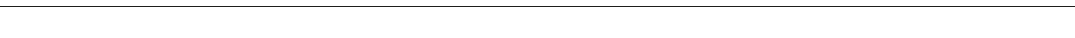
Fig. 7 Integration rules in the middle body patch. a Coronal slice showing the location of the fMRI-identi fi ed middle body patch in one monkey targeted for recording; dark black line indicates electrode. b Example stimuli used to probe integration rules in the middle body patch. The face image is from the FERET face database 51,52 . The object image and the monkey body image shown are similar to the one actually shown, but due to copyright reasons, we cannot show the originals. c Mean baseline-subtracted responses of neurons recorded in the middle body patch to stimuli from different object categories. d Mean response of cells in the middle body patch to a face and a body, presented in the con fi gurations indicated within each panel. Black lines represent the responses to the body-face pairs at fi ve different relative contrast levels. Green (red) lines represent responses to the constituent body (face) of the corresponding body-face pair when presented in isolation. e Same as c , for body-object pairs. Analogous to the face patch, body cells followed a winner- take-all rule for bodies in the contralateral visual fi eld, and an averaging rule for bodies in the ipsilateral visual fi eld. Body cells also followed a winner-take- all rule for bodies in the upper/lower visual fi elds when presented together with a non-body